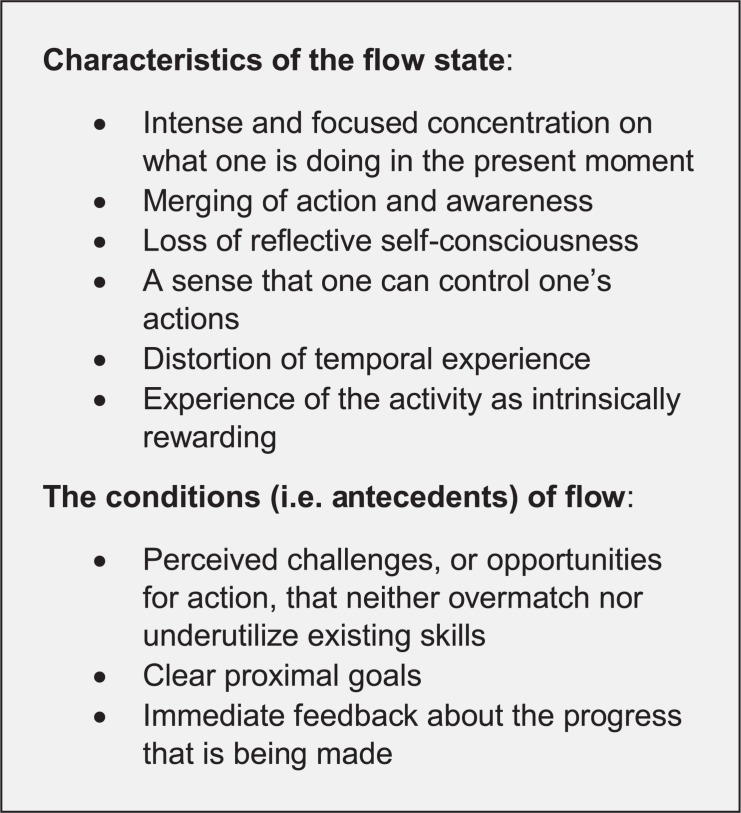
The characteristics and conditions of flow (from Nakamura and Csikszentmihalyi, 2002).